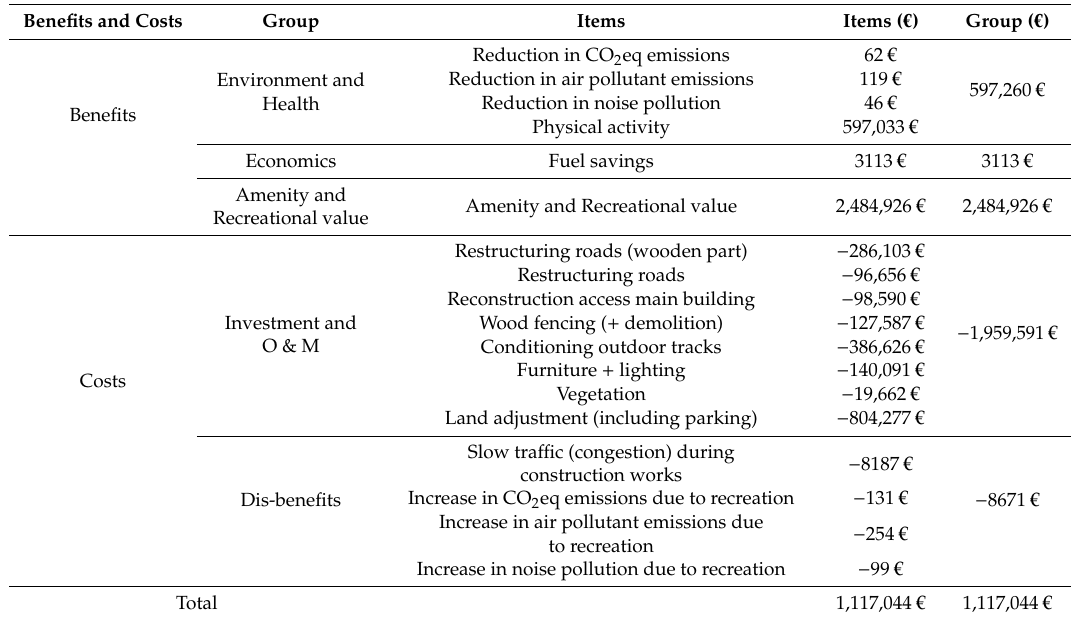
Table 4. Summary of Benefits and Costs of Thinking Fadura project. Time horizon 20 years and discount rate 3.5%.